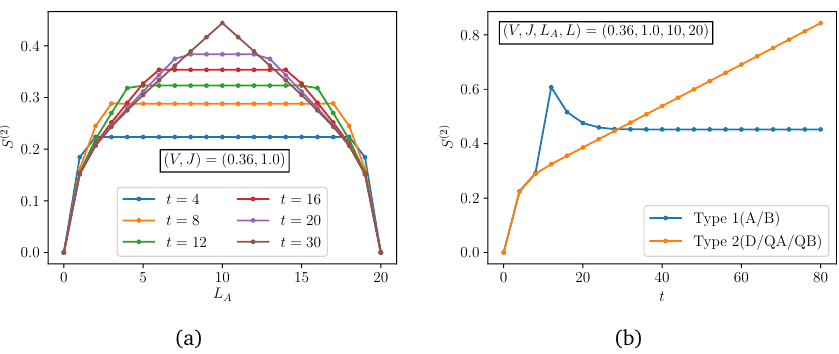
Figure 8: (a) The result for S ( 2 ) vs L parison between two saddles.